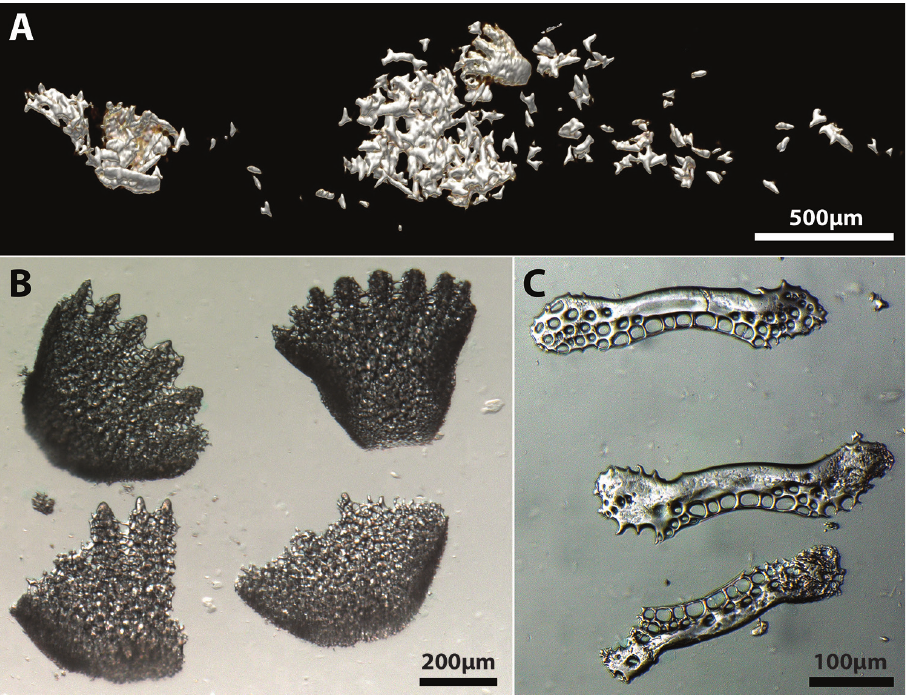
Figure 12. Gut content of Flexor incus. A Hard gut content of AIM MA655316, paratype, 23.0 mm SL, as revealed by CT scanning. Isolated elements from the gut of AIM MA655142, paratype, 20.0 mm SL B Stereomic ossicles tentatively identified as elements from the terminal disc of an echinoid C Rod-like elements tentatively identified as ossicles from the body of a